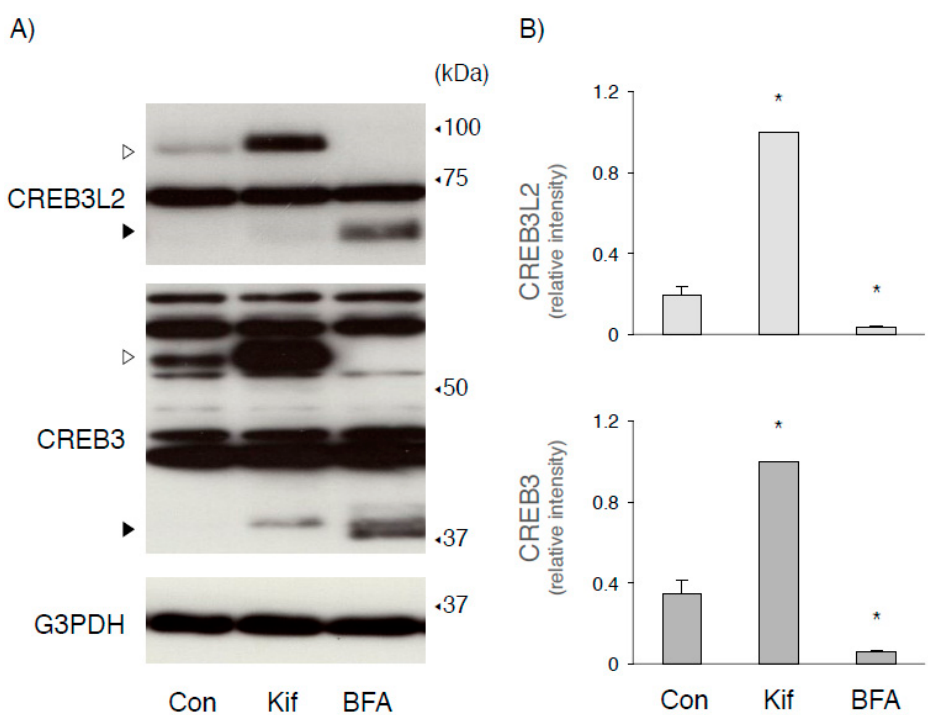
Figure 5. Treatment with kifunensine increased the levels of the CREB3 and CREB3L2 proteins in HEK293 cells. ( A ) HEK293 cells were treated with kifunensine (Kif, 5 µ g/mL), BFA (0.5 µ g/mL), or vehicle for 8 h. The expression of the indicated protein was detected as described in the Materials and Methods. Open and filled arrowheads indicate full-length mature and cleaved CREB3 and CREB3L2 proteins, respectively. Representative results of four independent cultures are shown. ( B ) The relative amounts of full-length CREB3 and CREB3L2 were evaluated as described in the considered “1”. Each value represents the mean ± SEM from four independent cultures.